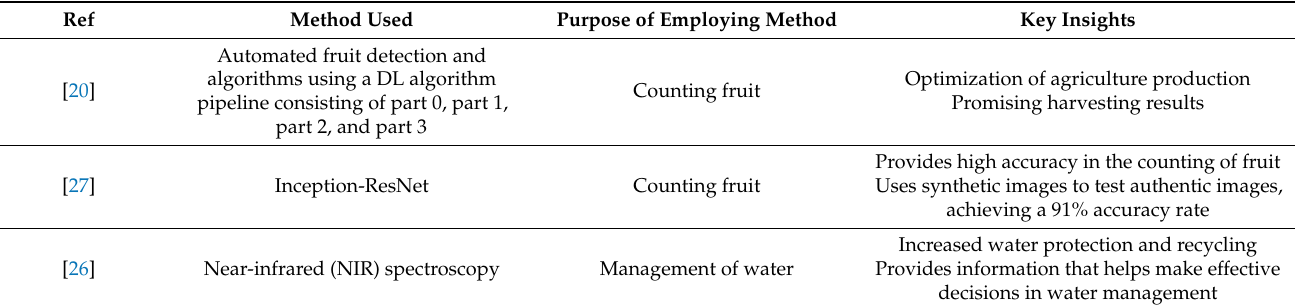
Table 4. Summary of different DL methods used in